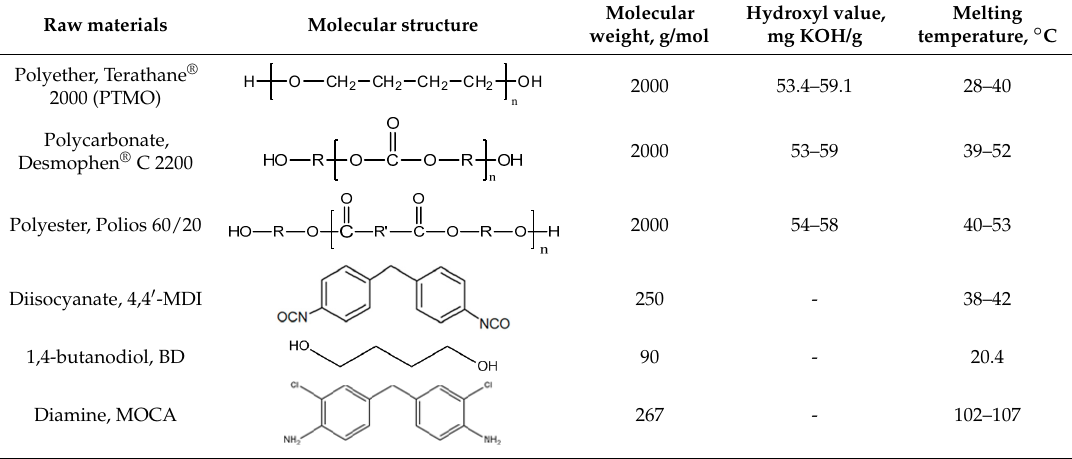
Table 1. Molecular structure and detailed specifications of the raw materials used for the synthesis. Raw materials